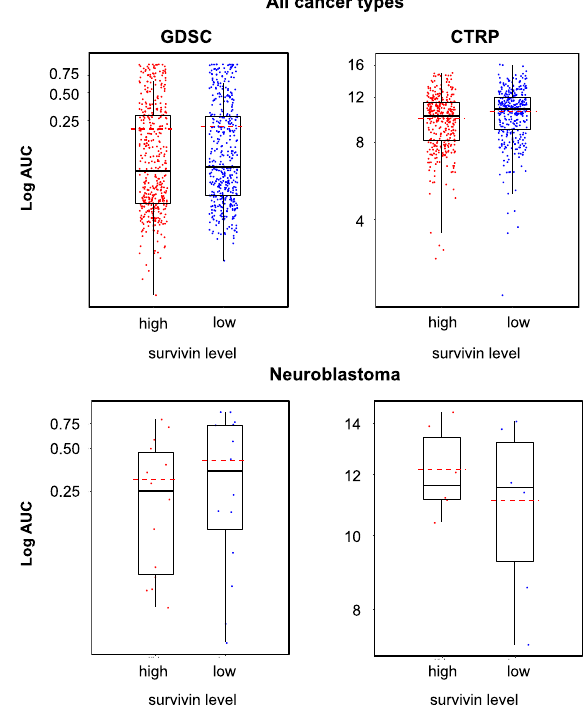
Figure 3. YM155 sensitivity in cell lines characterized by high or low survivin expression based on the analysis of GDSC and CTRP data, both determined across all investigated cancer types / cell lines (GDSC, p = 0.048; CTRP, p < 0.001) and in a neuroblastoma-specific analysis (GDSC, p = 0.425; CTRP, p = 0.699). Across all cell lines, high survivin expression was associated with increased YM155 sensitivity, but the YM155 sensitivity of individual cell lines could not be predicted based on the survivin levels.